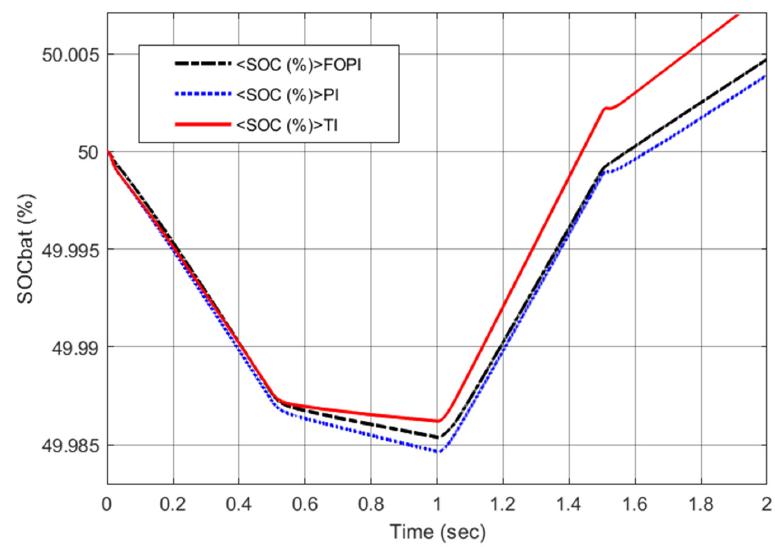
Figure 12. 𝑆𝑂𝐶 (cid:3029)(cid:3028)(cid:3047) in the PV system with a supercapacitor for the PI, FOPI, and TI controllers. Figure 12. SOC bat in the PV system with a supercapacitor for the PI, FOPI, and TI controllers. Table 5. Consumption of SOC bat for the PI, FOPI, and TI controllers.